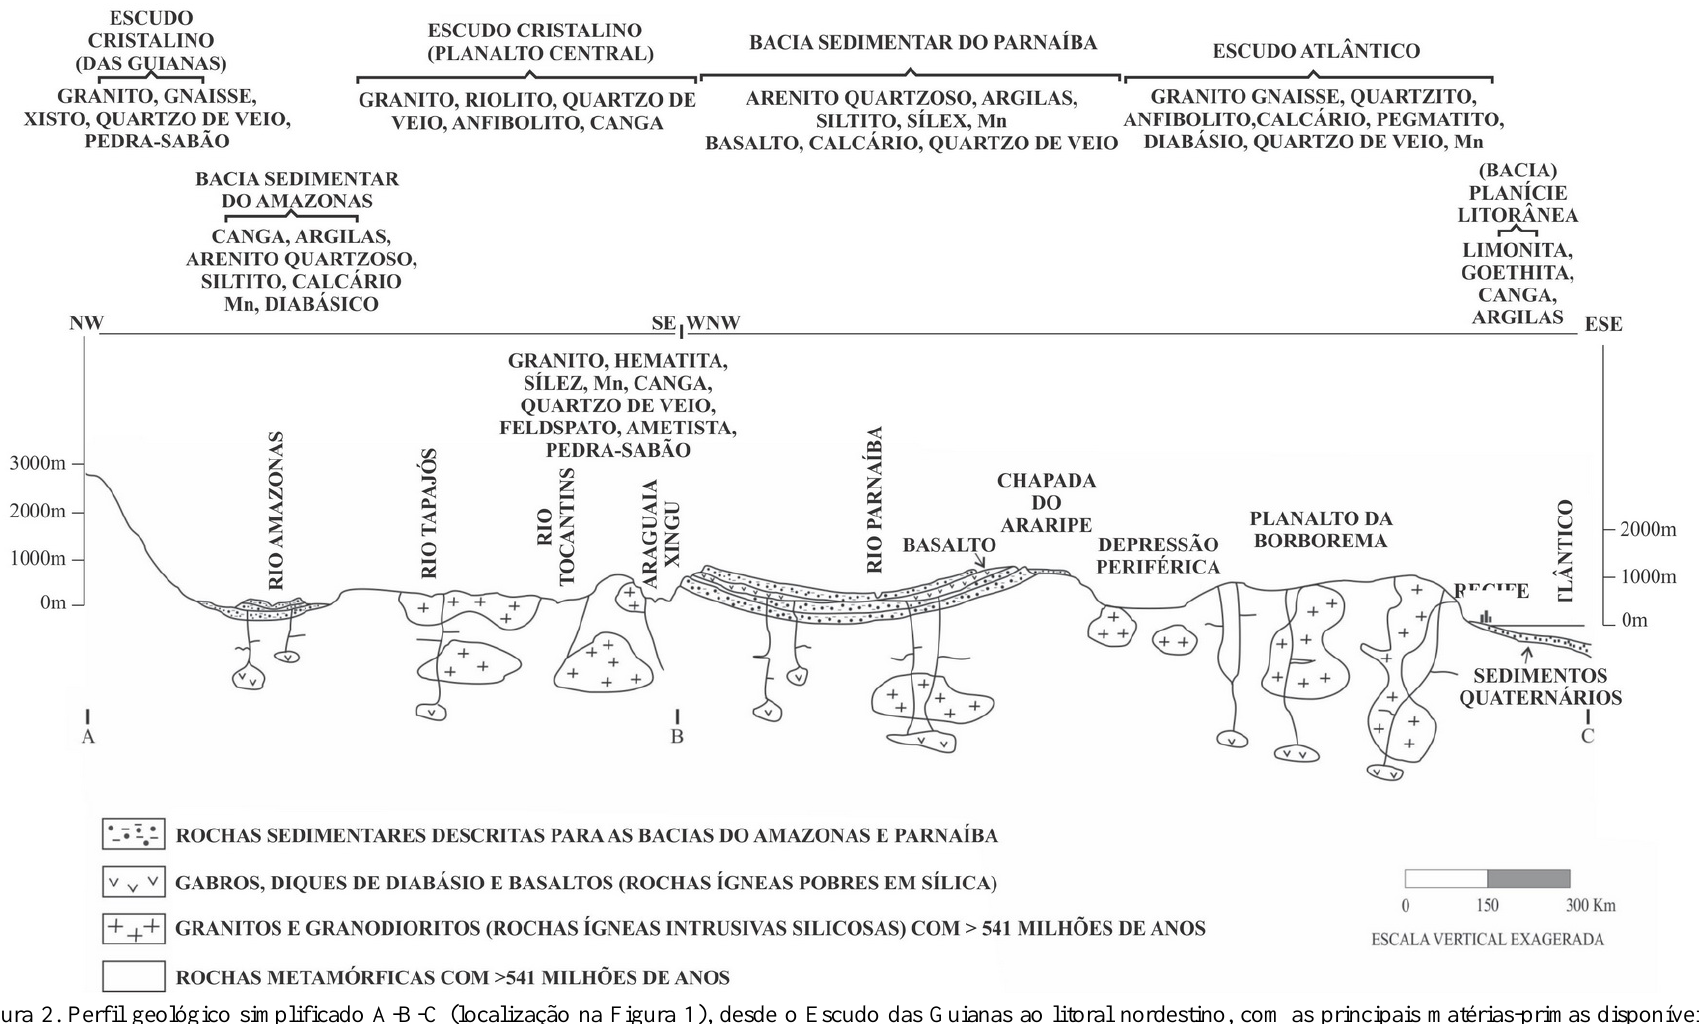
Figura 2. Perfil geológico simplificado A-B-C (localização na Figura 1), desde o Escudo das Guianas ao litoral nordestino, com as principais matérias-primas disponíveis. Fonte principal: Hasui et al. (2012). Figure 2. Geological simplified A-B-C profile (localization in the Figure 1), from the Guiana Shield to the Northeast Coast, with the main available lithic raw-materiais. Main source: Hasui et al.